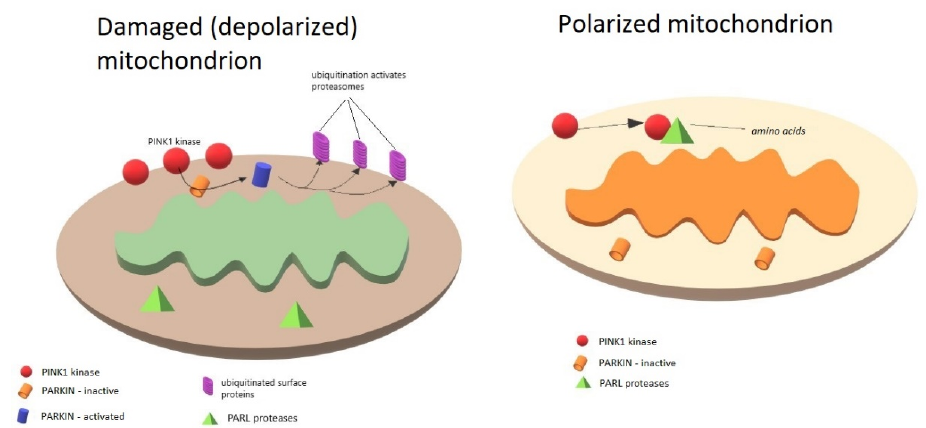
Figure 1. PINK1 / PARKIN pathway activation in polarized mitochondria. Depolarization of Figure 1. PINK1/PARKIN pathway activation in polarized mitochondria. Depolarization of mitochondria/mitochondrial damage activates PARKIN-dependent mitophagy by induction of PINK-1 kinase in the outer mitochondrial membrane (OMM). Loss of membrane potential necessary for component replacement is responsible for increased concentration of PINK1 in the OMM. PINK1 stabilizes and phosphorylates Parkin, which, when activated, is responsible for ubiquitinylation of proteins on mitochondrial surface, which is a signal for proteasomes to degrade the mitochondrion. In polarized mitochondria, PINK1 is continuously being imported into the mitochondrial healthy